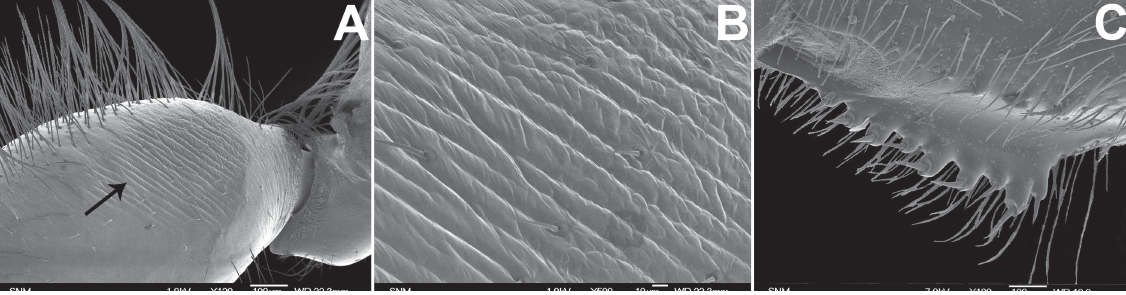
Fig. 6. Megatrigon spp., metafemur, ♂ (SeM). A . Megatrigon argentifrons sp. nov., proximal half posterodorsally with striae (arrow). B . M. argentifrons sp. nov., enlarged striae. C . M. magnicornis sp. nov., anteroventral preapical flange